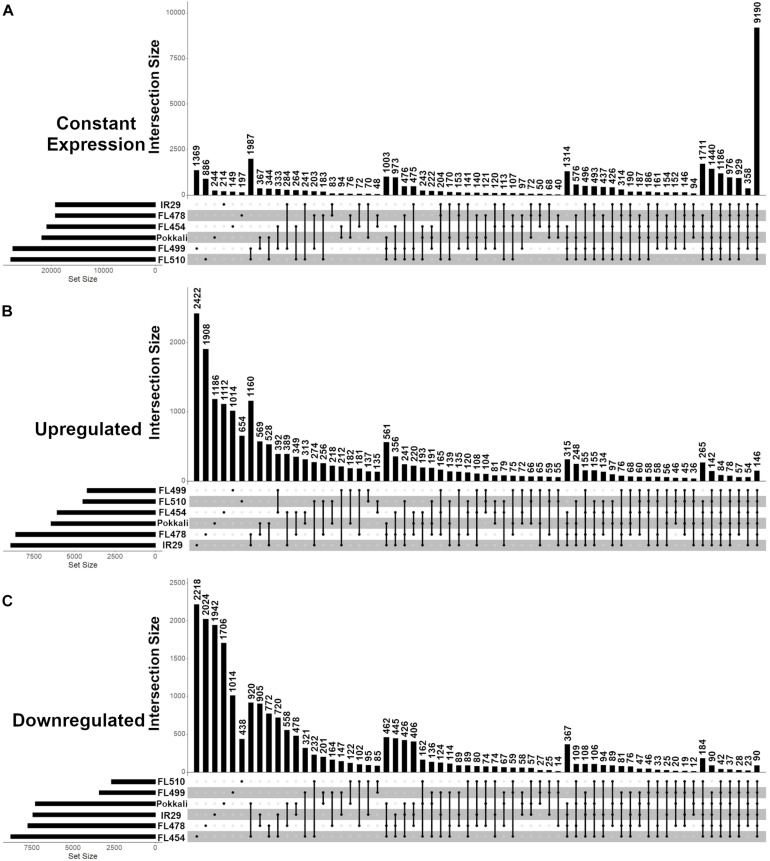
Distribution of protein-coding genes with unchanged (constant), upregulated or downregulated expression across the IR29 × Pokkali comparative panel as revealed by temporal RNA-Seq analysis before (0 h) and during (24, 48, 72, 144 h) salt stress at EC = 12 ds m– 1. Analysis was performed from V5 to V12 stage of vegetative growth. (A) Genes with unchanged (constant) expression had no significant changes in transcript abundance (< 2 and > -2 log2-fold) across all time-points. (B) Upregulated genes had significant increase in transcript abundance (> 2 log2-fold) relative to 0 h in at least one time point at EC = 12 ds m– 1. (C) Downregulated genes had significant decrease in transcript abundance (< -2 log2-fold) relative to 0 h in at least one time point at EC = 12 ds m– 1. Upset graphs accommodate all possible pair-wise comparisons and corresponding set intersections across pair-wise comparisons. The horizontal bar graph at the bottom left represents the total set size in each genotype, while the vertical bar graph represents the abundance of genes in each set, as dictated by the matrix at the bottom. The matrix indicates which genotype(s) combine for the vertical bar graph. The super-tolerant FL510 and super-sensitive FL499 had the least number of differentially expressed genes as shown in (A–C). The tolerant FL478 and sensitive parent IR29 had the highest number of upregulated genes, followed by the tolerant donor parent Pokkali and sensitive FL454. Meanwhile, FL454 has the highest number of downregulated genes, followed by FL478, IR29, and Pokkali. The overlap between the subsets of stress responsive genes in FL510 and FL499 are minimal, indicating their responses are unique from each other.